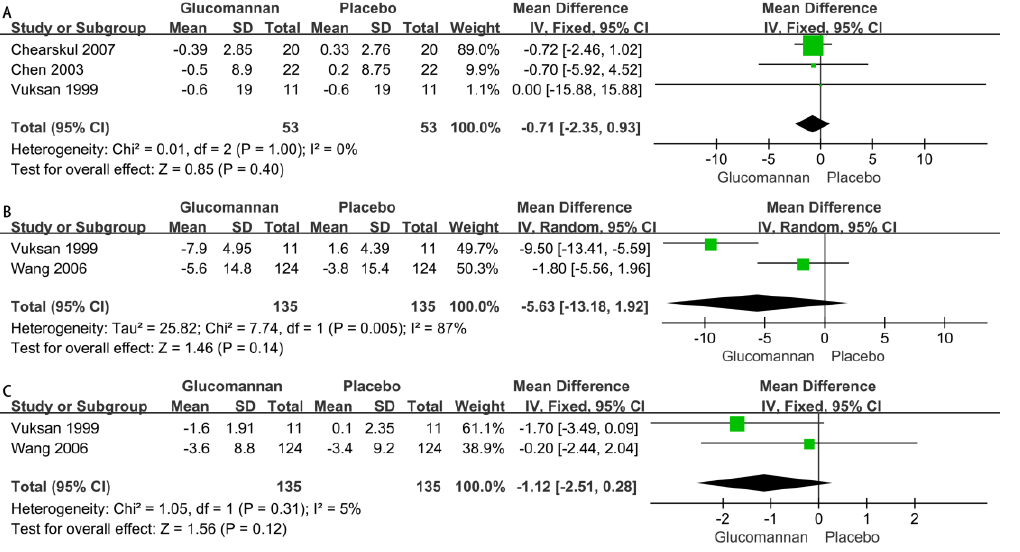
Figure 6. Forest plot of studies [20,22,23,25] on the effect of glucomannan intake on physical examination index included in this analysis. The effects of glucomannan on BW ( A ), SBP ( B ), and DBP ( C ), where green boxes indicate the odds ratio of the original research data and black diamonds indicate the overall odds ratio of studies included.